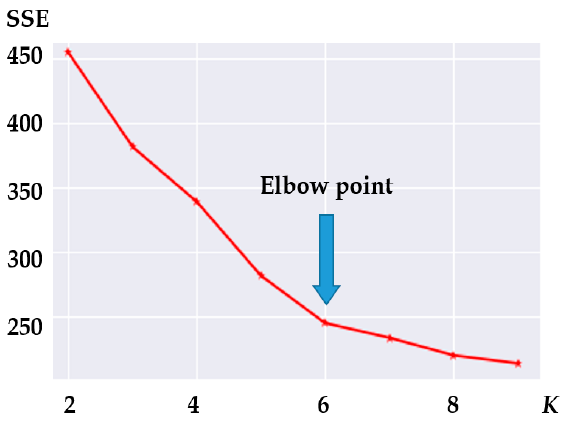
Figure 9. Sum of squared errors with elbow method for finding optimal K.